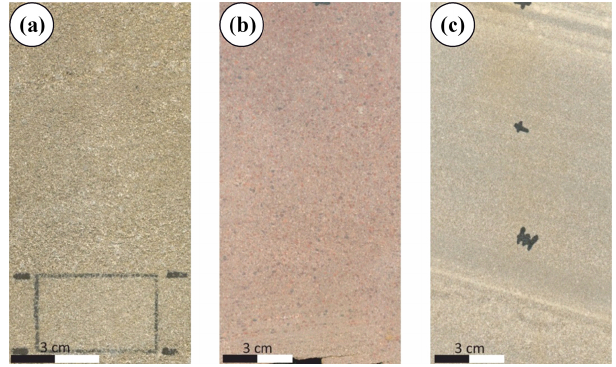
Figure 4. Different examples of lithotypes of the analysed Permian sandstones. In (a) a brownish, plane-horizontal stratified medium- grained sandstone type is shown. In (b) a red, massive, medium coarse-grained sandstone type is visualized and in (c) a greyish, obliquely bedded fine-medium-grained sandstone type is